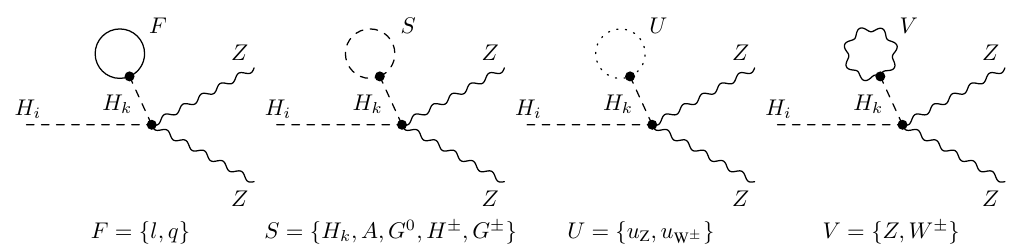
Figure 6 . Tadpole contributions to the vertex diagrams to be included in the decay H i ! ZZ in the alternative tadpole